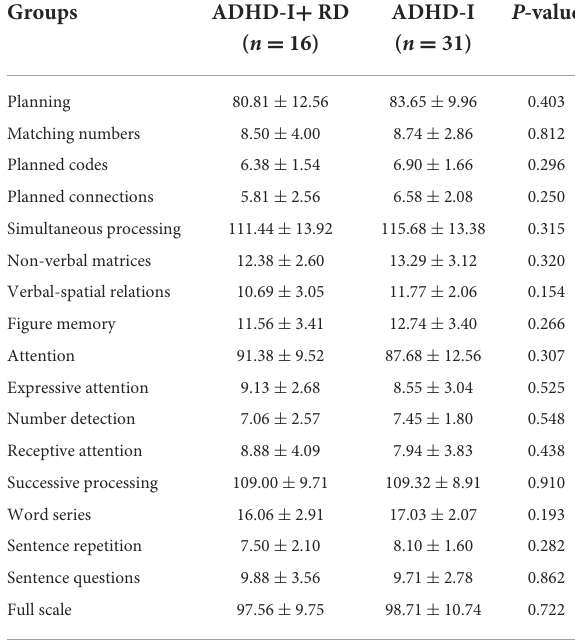
TABLE 3B DN: CAS full scale and subscale scores for ADHD-I + RD subgroup and ADHD-I subgroup. Groups